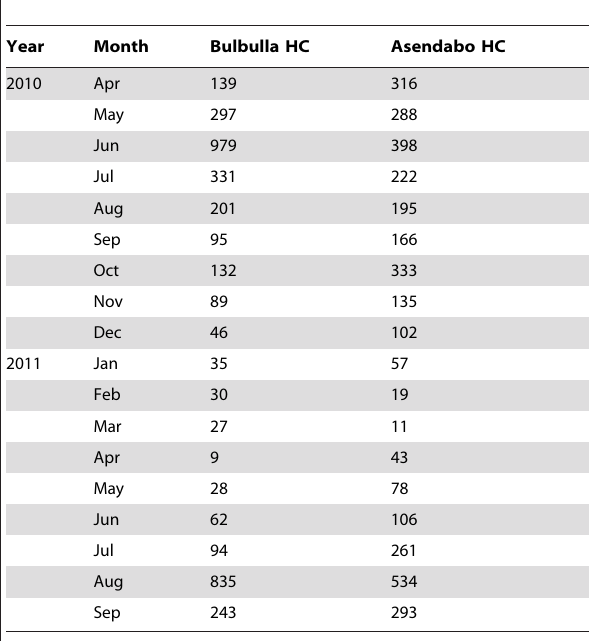
Table 1. Monthly malaria treatments at Bulbulla and Asendabo health centers.